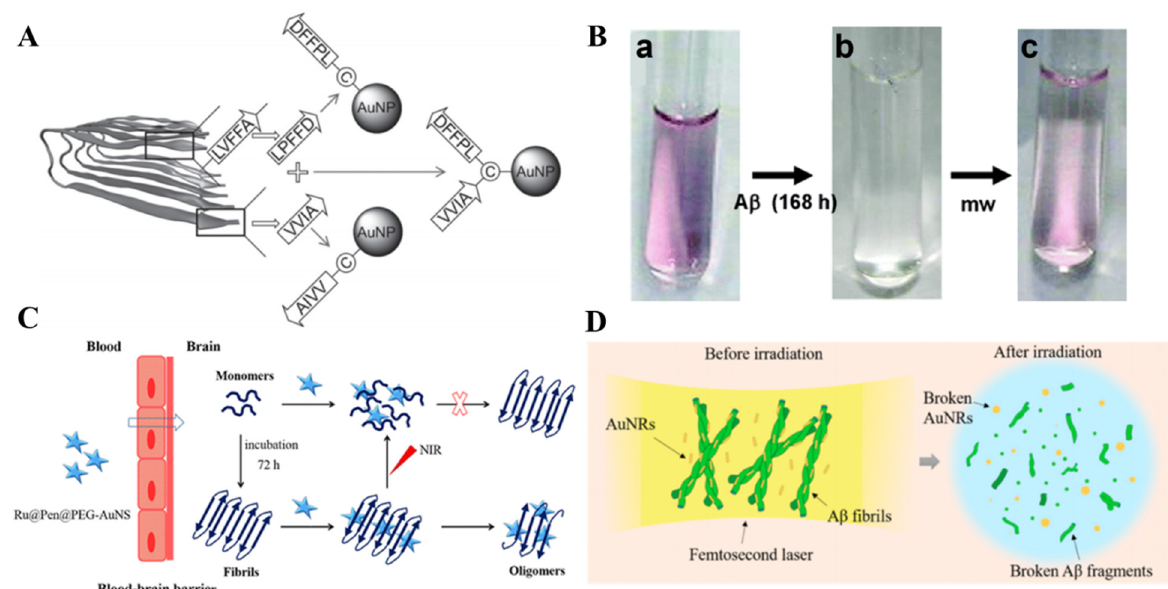
Figure 2. ( A ) Schematic of the design of peptide hybrid-functionalized AuNPs. Reprinted with permission from reference [49]. Copyright 2017 Wiley-VCH. ( B ) Schematic of remote dissolution of A β 1–42 precipitates. (a) AuNPCys-PEP solution mixed with A β 1–42 before the incubation. UVvis absorption peak at 527 nm. (b) After incubation of AuNPCys-PEP with A β 1–42 for 7 days at 37 ◦ C. No UV-vis absorption peak. (c) Irradiation of B for 8 h with 0.1 W and 12 GHz microwave field. UV-vis absorption peak at 527 nm. Reprinted with permission from reference [53]. Copyright 2006 American Chemical Society. ( C ) Schematic of Pen-modified Au nanostars for the NIR photothermal treatment of AD. Reprinted with permission from reference [57]. Copyright 2019 American Chemical Society. ( D ) Schematic of highly efficient destruction of amyloid- β fibrils by femtosecond laser-induced nanoexplosion of gold nanorods. Reprinted with permission from reference [58]. Copyright 2016 American Chemical Society.